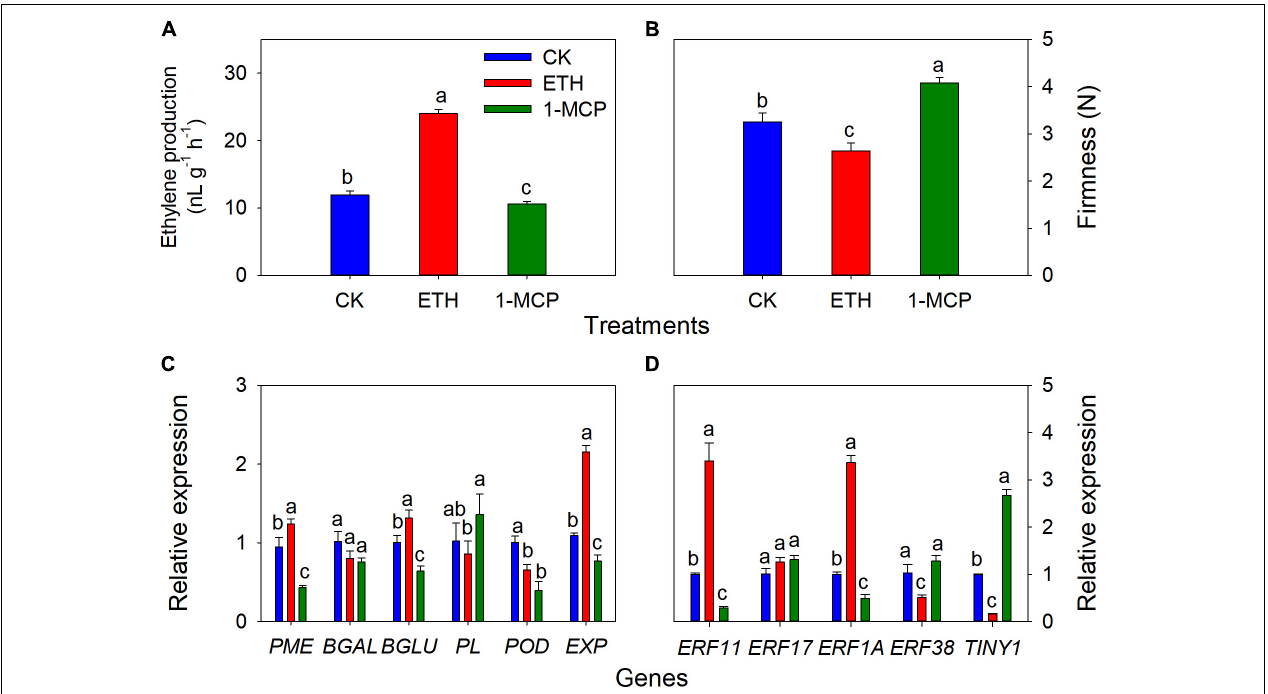
FIGURE 7 | Changes in ethylene production of whole seeds, aril firmness, quantitative real-time PCR (RT-qPCR) of some cell wall modification-relevant genes, and five ethylene response factors in T. grandis at 9 days of treatments of 0 (CK), 3,000 µ L L − 1 ethephon, or 200 nL L − 1 1-MCP. (A) Ethylene production of whole seeds; (B) aril firmness; (C) RT-qPCR results of some cell wall modification-relevant genes; (D) RT-qPCR results of several ethylene response factors. Different lowercase letters indicate a significant difference at different growth stages by Duncan’s multiple range test ( P < 0.05). N =